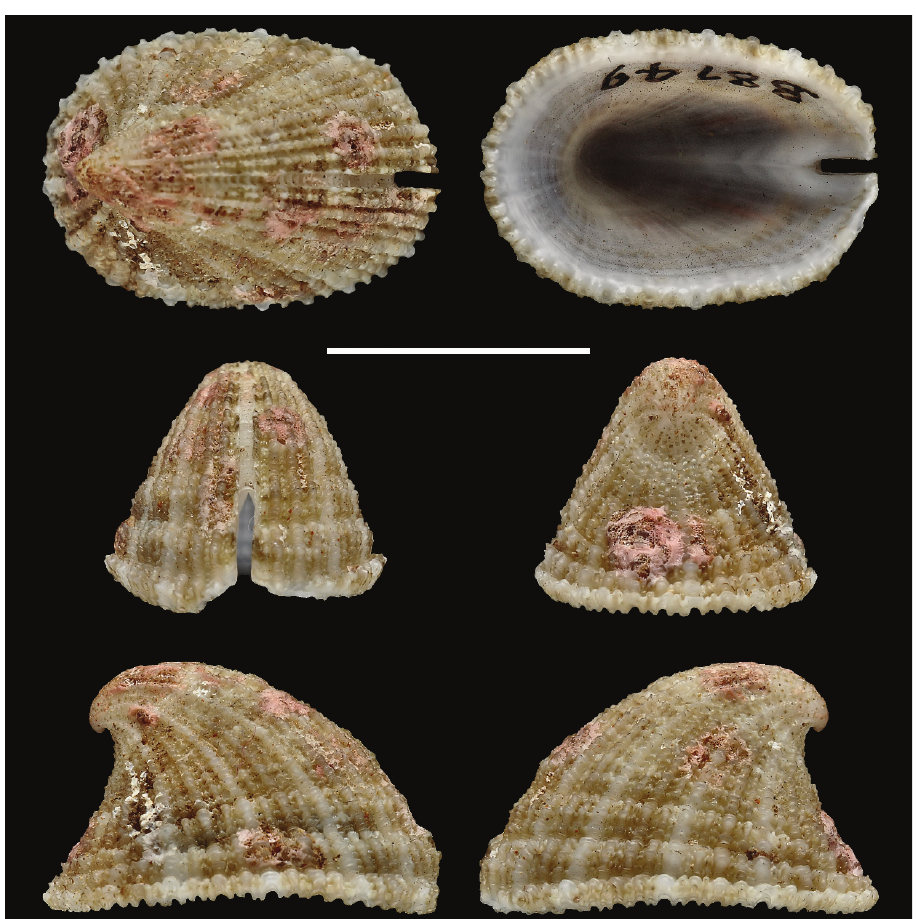
Figure 10. Emarginula viridicana Herbert & Kilburn, 1986. Holotype T3021/NMSA-MOL 0B8749. Scale bar: 10